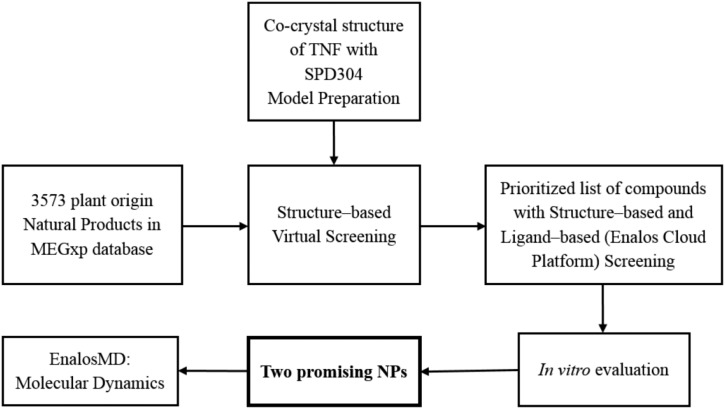
Strategy for the identification of NP TNF inhibitors.